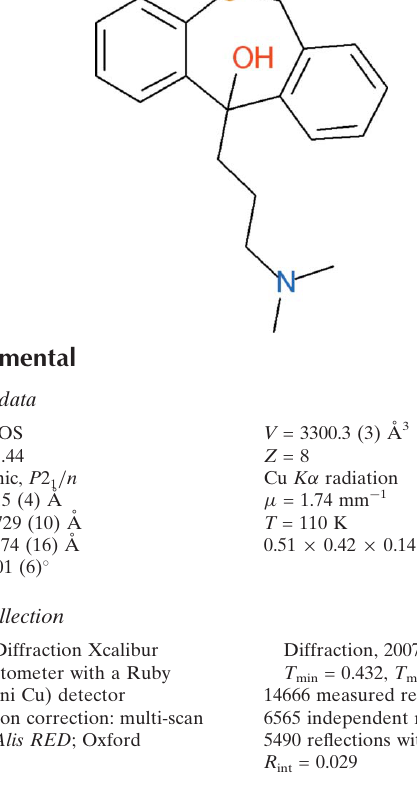
Data collection Oxford Diffraction Xcalibur diffractometer with a Ruby (Gemini Cu) detector Absorption correction: multi-scan